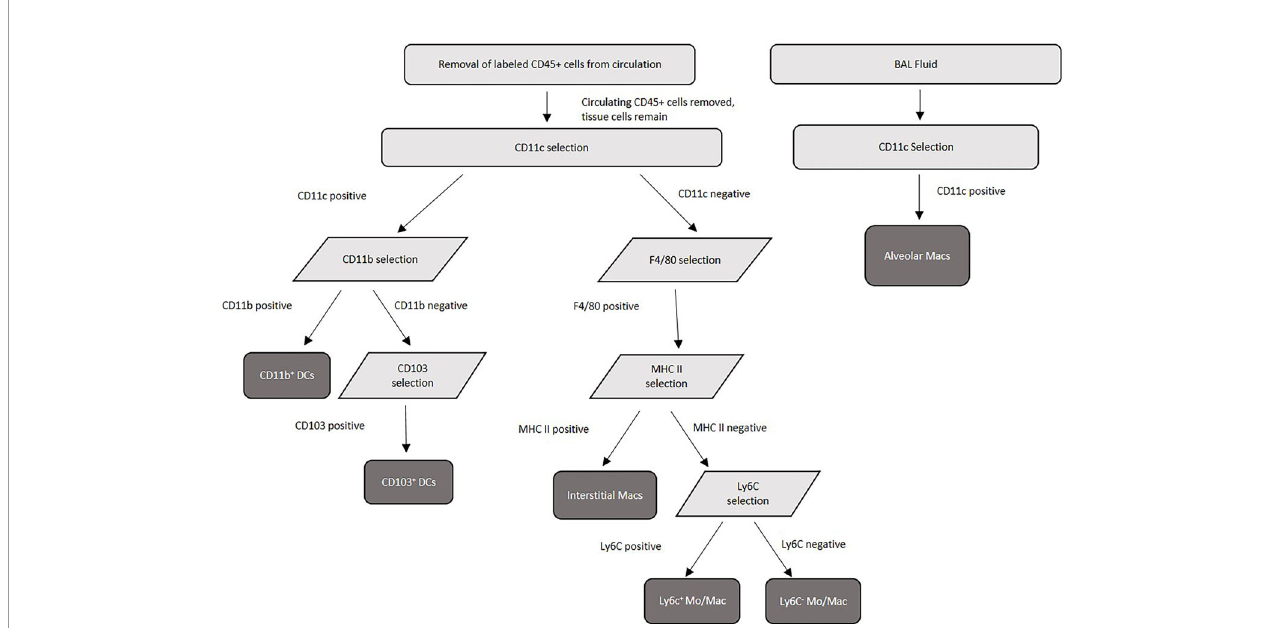
FIGURE 1 | Puri fi cation scheme for murine pulmonary tissue macrophage and dendritic cell subsets. Lung tissue was pooled from 20 mice/experiment, collagenase digested, then separated into single-cell suspensions before magnetic separation. Following lung tissue collagenase digestion, labeled FITC-CD45 + cells from the circulation were removed by anti-FITC magnetic separation, and tissue macrophage and dendritic cell subsets were separated using a series of surface antibody- speci fi c magnetic separations. Cell purity was veri fi ed by fl ow cytometry